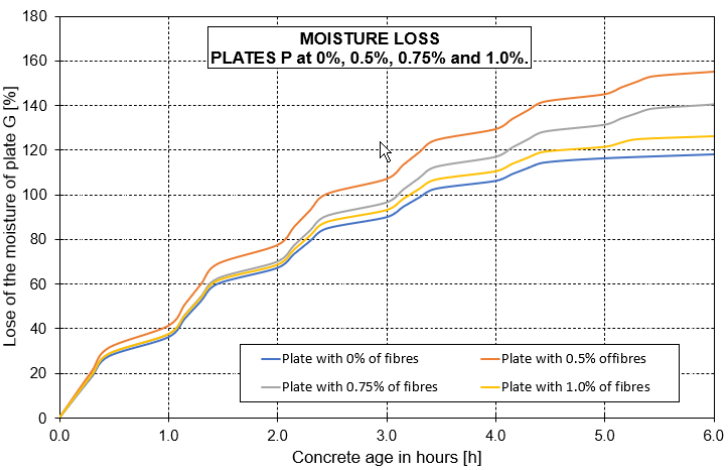
Figure 14. Moisture loss rate.